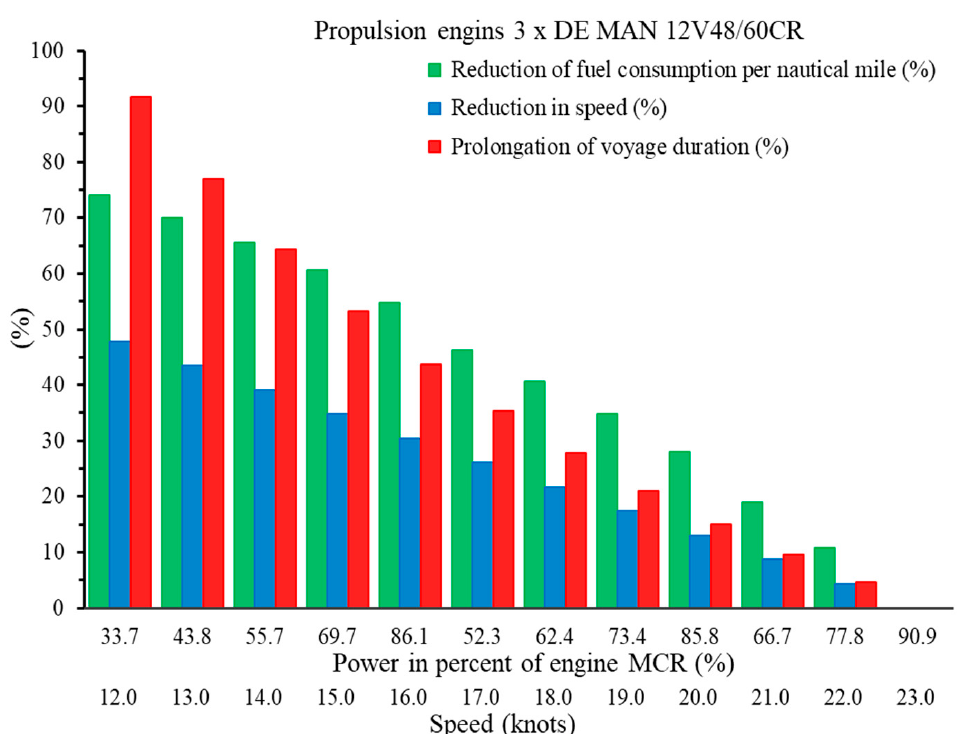
Figure 14. Propulsion with three medium-speed diesel engines—Configuration 3.